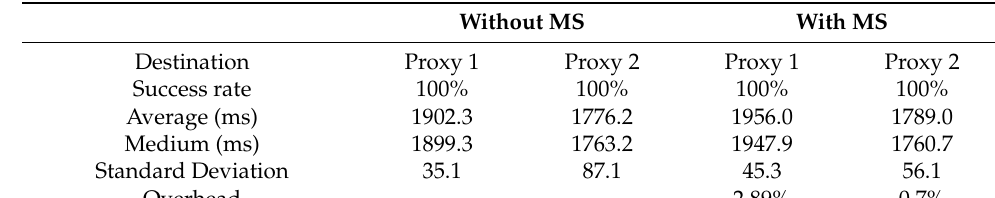
Table 4. Downloading a 760 KB image under normal situation.